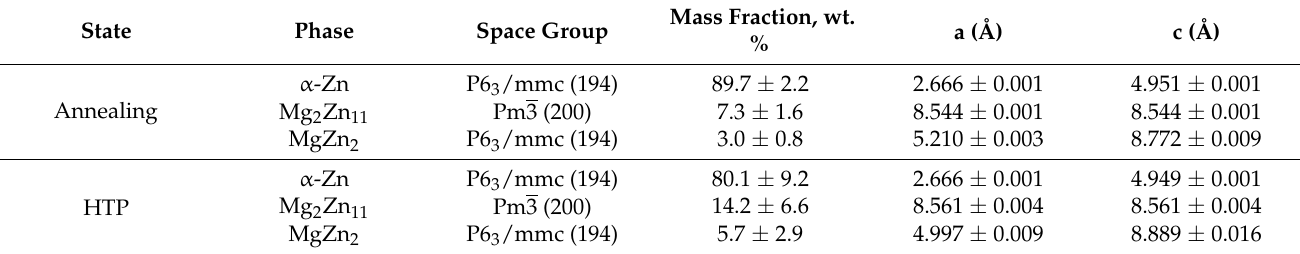
Figure 3. X-ray diffraction patterns of the Zn – 1%Mg alloy before ( a ) and after HPT ( b ). Table 1. Results of XRD analysis (Rietveld method) of the Zn–1%Mg alloy in the initial state and after HPT processing.